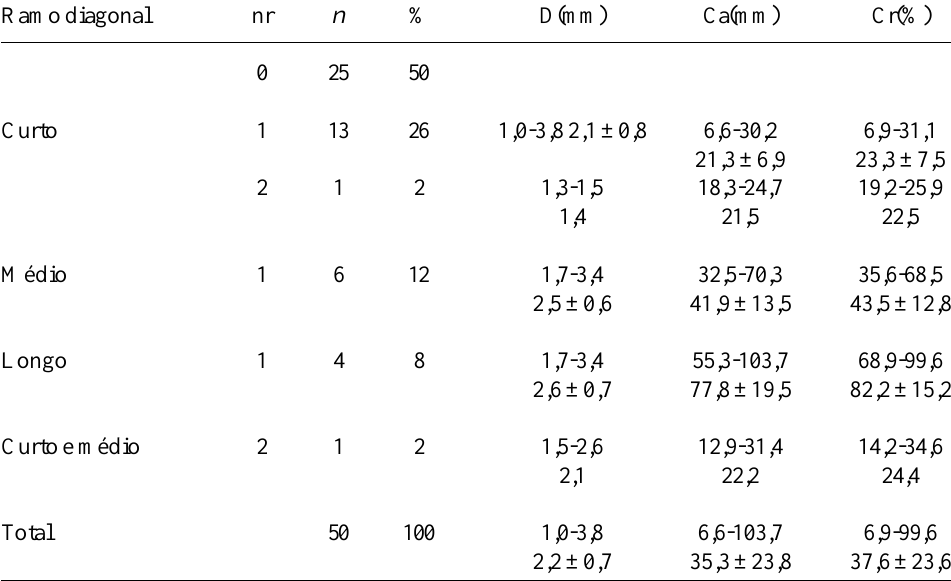
Tabela 1. Distribuição da freqüência, do número de ramos, do diâmetro e dos comprimentos absoluto e relativo do ramo diagonal, conforme o tipo.